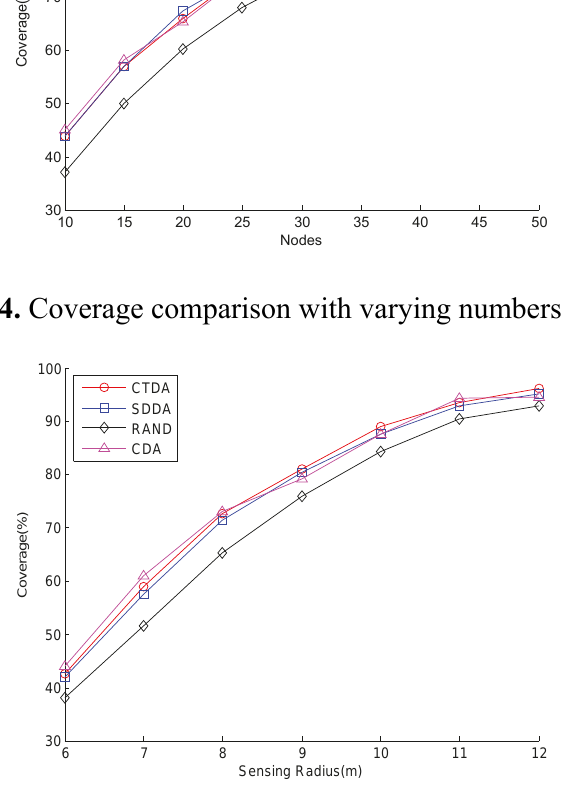
Figure 5. Coverage comparison with varying sensing